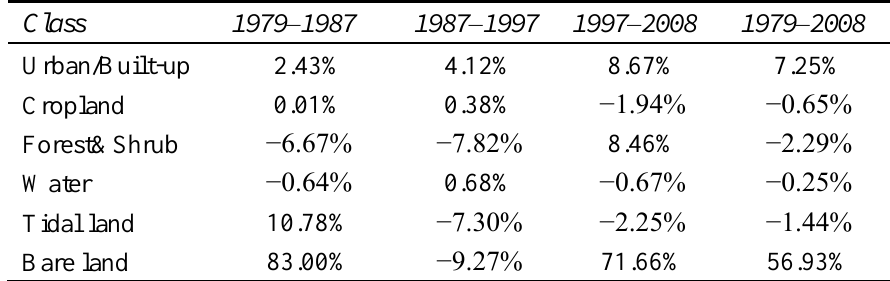
Table 9. The single land use dynamic degree of study area in different periods.